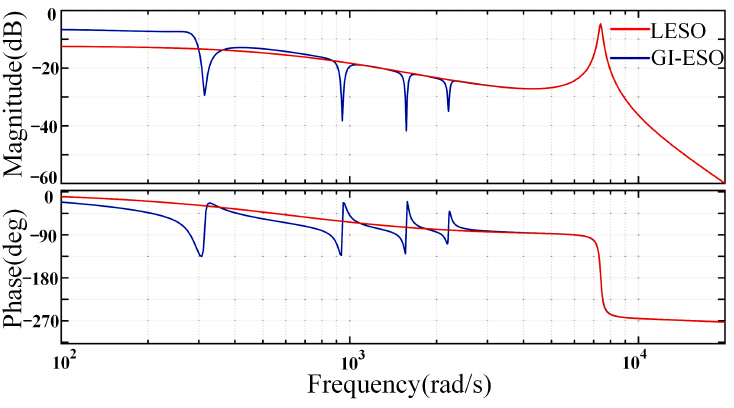
for GI-ESO and LESO. g